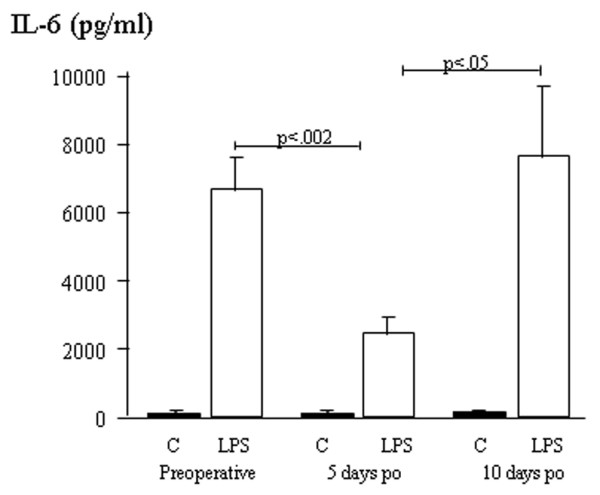
Ex vivo production of interleukin-6. Preoperative and postoperative (po) interleukin (IL)-6 levels in whole blood culture supernatant. Values are expressed as means and SEM (error bars). IL-6 production was significantly increased after stimulation with lipopolysaccharide (LPS; white), in comparison with the unstimulated control (C; black) at all time points. In comparison with preoperative levels, IL-6 production after stimulation with LPS significantly decreased 5 days after operation (P < 0.002) but again reached preoperative levels 10 days after operation.